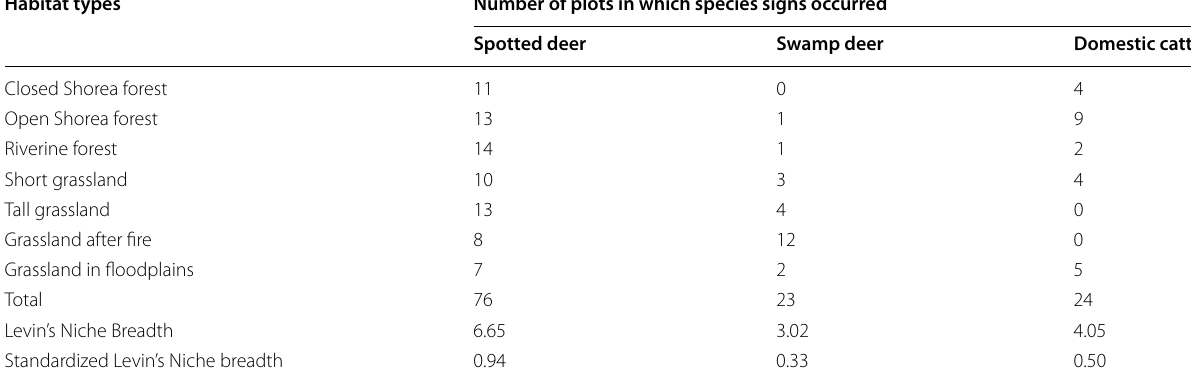
This table shows the number of plots in which the focused species signs were found in different habitats present in SNP and the calculated niche breath. Spotted deer had the highest niche breadth